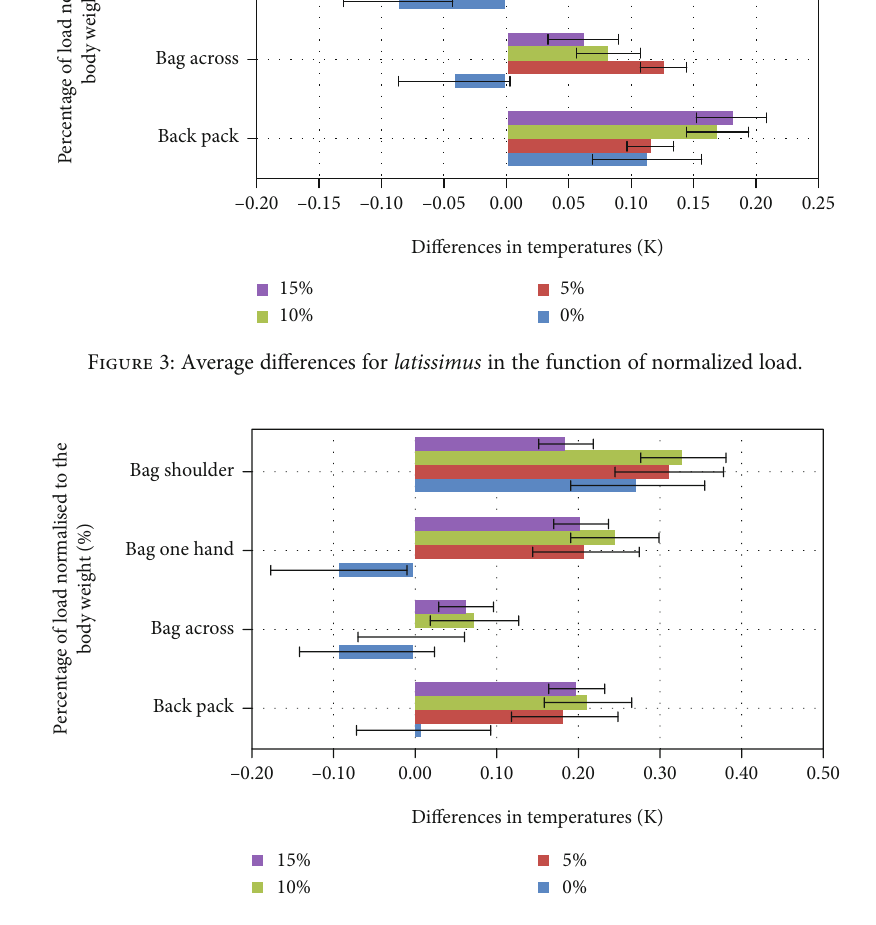
Figure 4: Average di ff erences for trapezius in the function of normalized load.